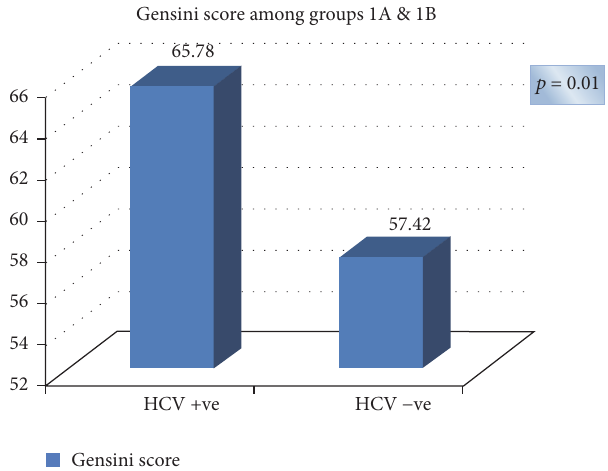
Figure 1: Gensini score among HCV Ab +ve and − ve groups.